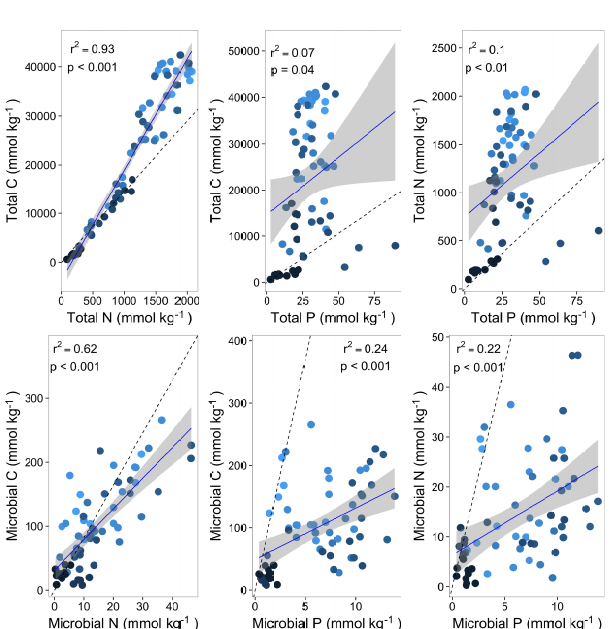
Figure 1. The stoichiometry of total soil C, N and P, and soil micro- bial C, N and P (molar ratios). The points are coloured according to the elevation gradient (194–3400ma.s.l.), with darker points for lower elevation sites and lighter points for higher elevation sites. The solid lines are linear regressions between total and microbial elements (model parameters are reported in the top-right of each panel). The shaded areas represent ± 1 SE. The dashed lines rep- resent the stoichiometric scaling of C:N:P from a recent global meta-analysis of forests (212 : 15 : 1 in soils and 74 : 9 : 1 in micro- bial biomass; Cleveland and Liptzin,